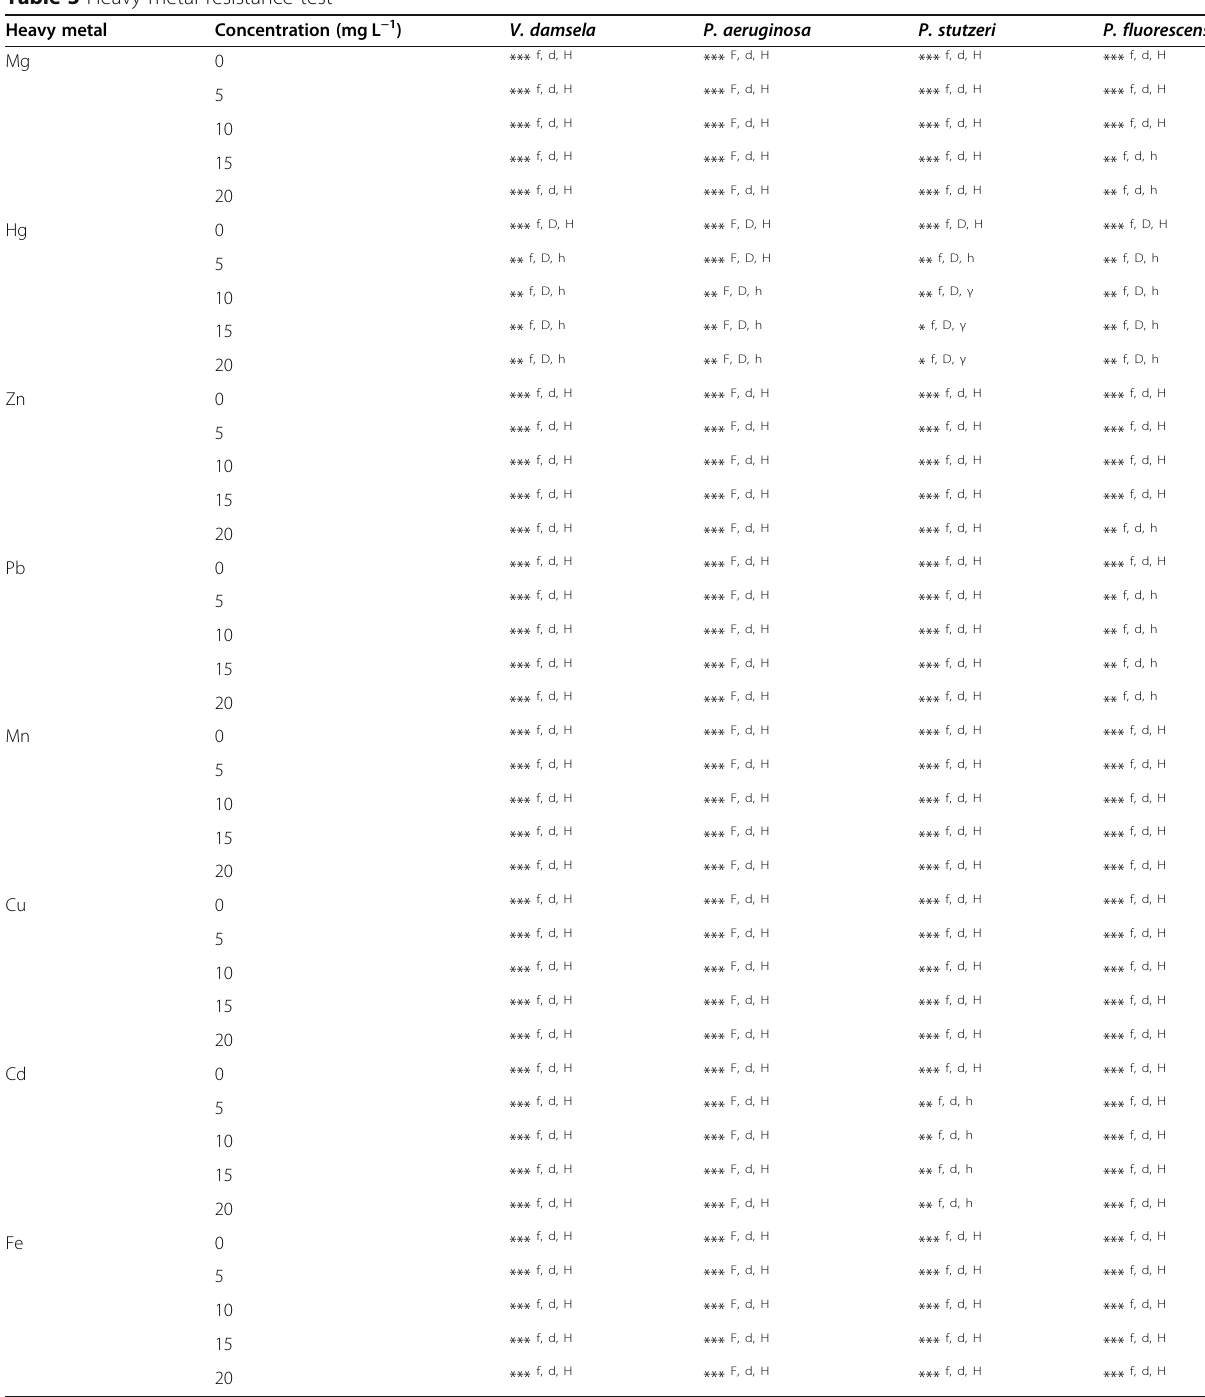
Table 3 Heavy metal resistance